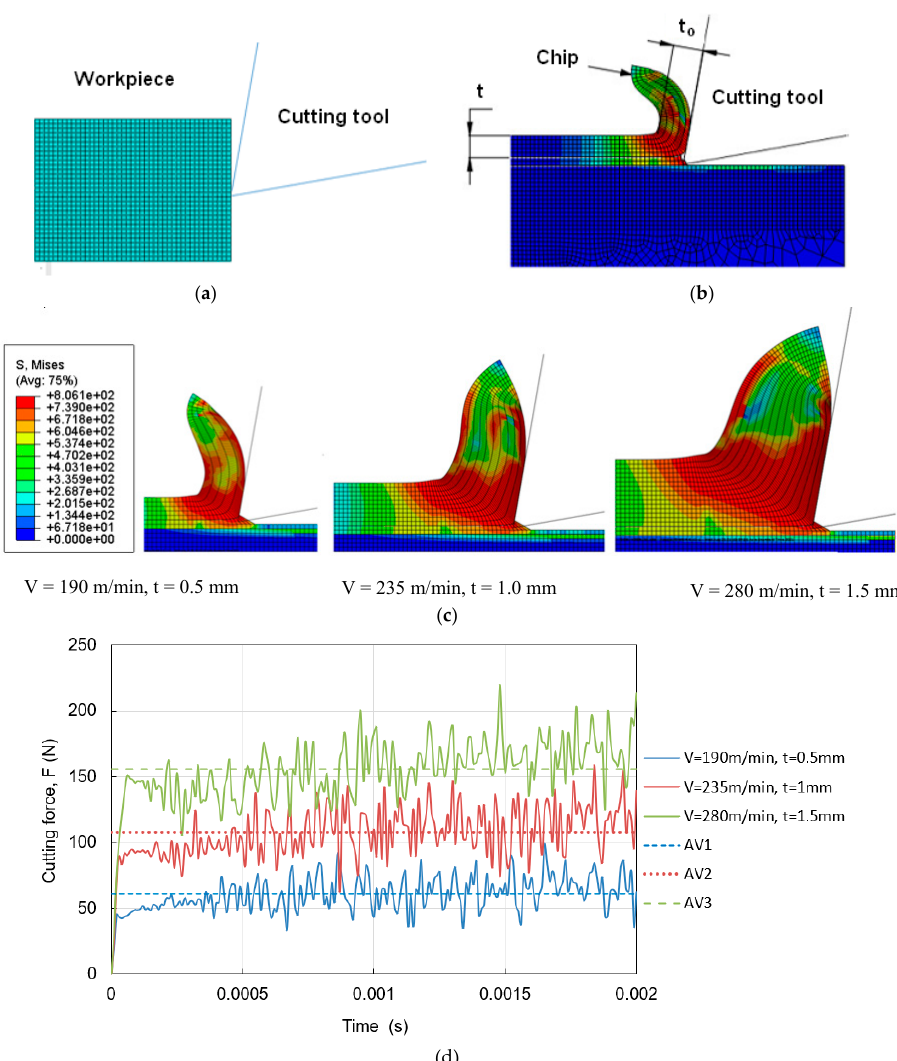
Figure 4. 2D FEM-based framework in preliminary milling ( a ), FEM chip thickness measurement ( b ), chip formation ( c ), and evolution of F based on the reference points of the cutting tool in FEM corresponding to preliminary experiments ( d ) at various cutting